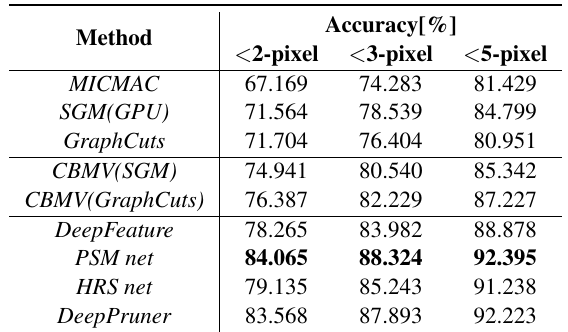
Table 3. Evaluation of methods on testing data. For SGM(GPU) , only evaluate disparity smaller than 128, for other methods max- imum disparity is